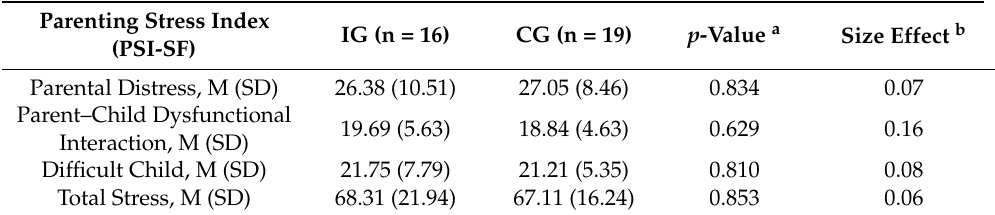
Table 5. Results of parenting Stress Index (PSI-SF) post-intervention in the intervention group (IG), and control group